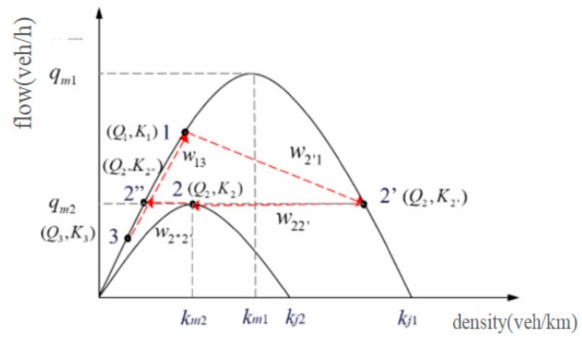
Figure 4. Diagram of flow–density after a traffic accident in the extra-long tunnel.